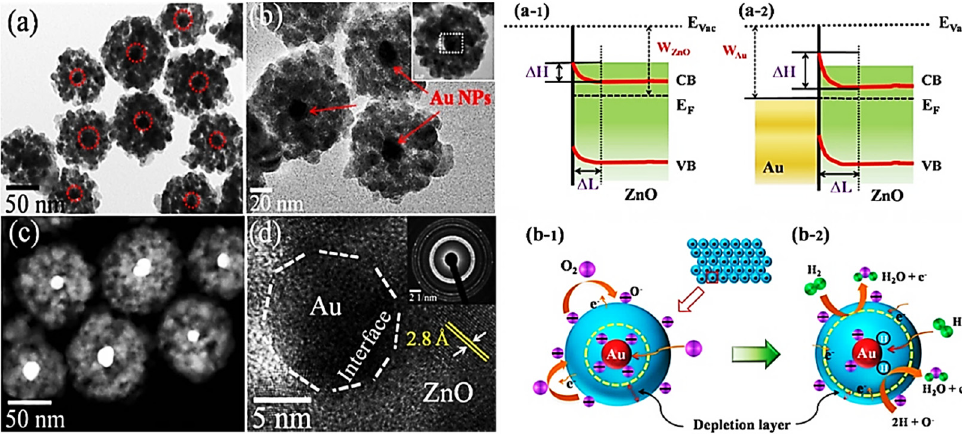
Figure 13. ( a – d ). TEM images of Au-ZnO C-S NPs and (( a-1 )–( b-2 )) the corresponding H 2 gas-sensing mechanism of Au-ZnO C-S NPs. Reproduced from [90] with the permission of Elsevier. Majhi et al. [91] further synthesized p- type Au-NiO-based C-S NPs and investigated their ethanol (C 2 H 5 OH)-sensing properties at low temperatures. The highest response of Au-NiO C-S NPs toward 100 ppm C 2 H 5 OH was 2.54 in comparison to 1.88 for pristine NiO NPs. The operating temperature of Au-NiO C-S NPs was lower (200 °C) than that of the pristine NiO NPs (300 °C). The formation of Au-NiO heterojunctions was responsible for the enhanced response to C 2 H 5 OH gas (Figure 14c). Majhi et al. [92] also reported a p- n heterojunction based on PdO-ZnO C-S NPs for acetaldehyde gas sensing. The as-pre- pared PdO-ZnO p-n heterojunction C-S NPs were tested for many gases, and the highest sensing response of 76 ( R a /R g ) was observed for 100 ppm acetaldehyde gas at 350 °C in comparison to that for pristine ZnO NPs ( R a /R g = 18). The enhanced sensitivity of PdO- ZnO C-S NPs was attributed to the formation of a p-n heterojunction structure, the cata- lytic effect of PdO NPs, and the high surface area of the obtained materials. Recently, Yu et al. investigated the sensing properties of noble metal alloy-based metal–oxide C-S NPs [94]. The authors synthesized AuPd alloy @ZnO C-S NPs and examined their H 2 gas-sensing properties. Different compositions of AuPd alloys, such as Pd 20 Au 80 , Pd 35 Au 65 , and Pd 50 Au 50 , were individually used to prepare C-S NPs. When tested for different gases, the Pd 35 Au 65 -ZnO C-S NP-based sensor showed an enhanced response toward 100 ppm H 2 , among other gases, with a high selectivity at 300 °C. This was attributed to the synergistic effect of the AuPd alloy and ZnO with the ES effect and the formation of the PdH x com- ponent due to the reaction with dissociated hydrogen atoms [94].